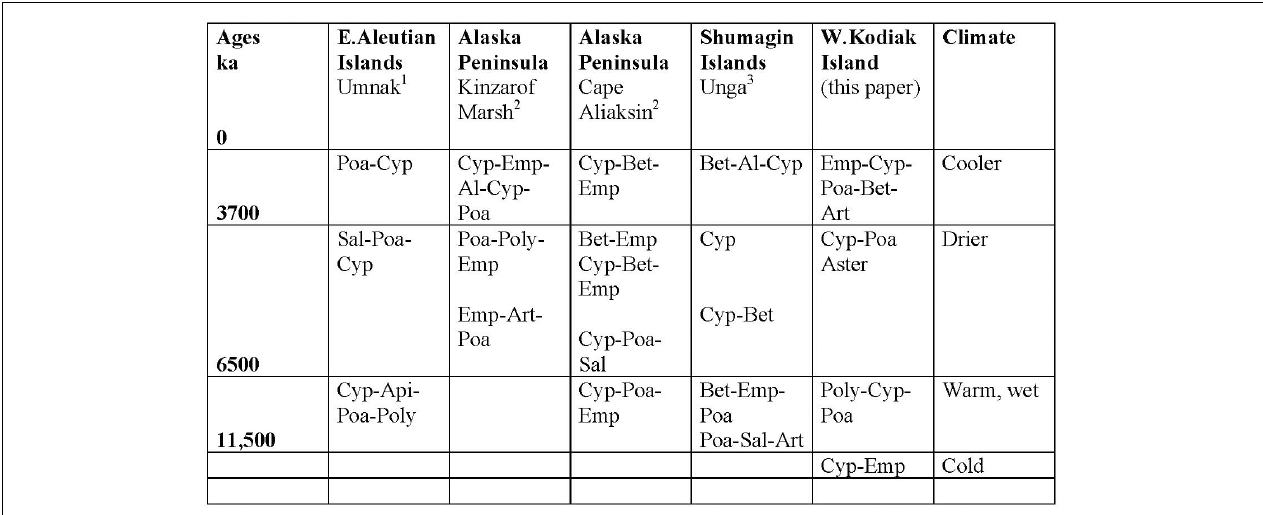
FIGURE 9 | Regional chart of pollen and spore dominance on Kodiak Island compared with sites in the Aleutians, the Shumigan Islands, and the western Alaskan Peninsula, along with inferred climate. Al, Alnus; Ap, Apiaceae; Art, Artemisia; Aster, Asteraceae; Bet, Betula; Cyp, Cyperaceae; Emp, Empetrum; Poa, Poaceae; Poly, Polypodiaceae; Sal, Salicaceae. Heusser, 1973; Heusser, 1983; Jordan and Krumhardt, 2003.